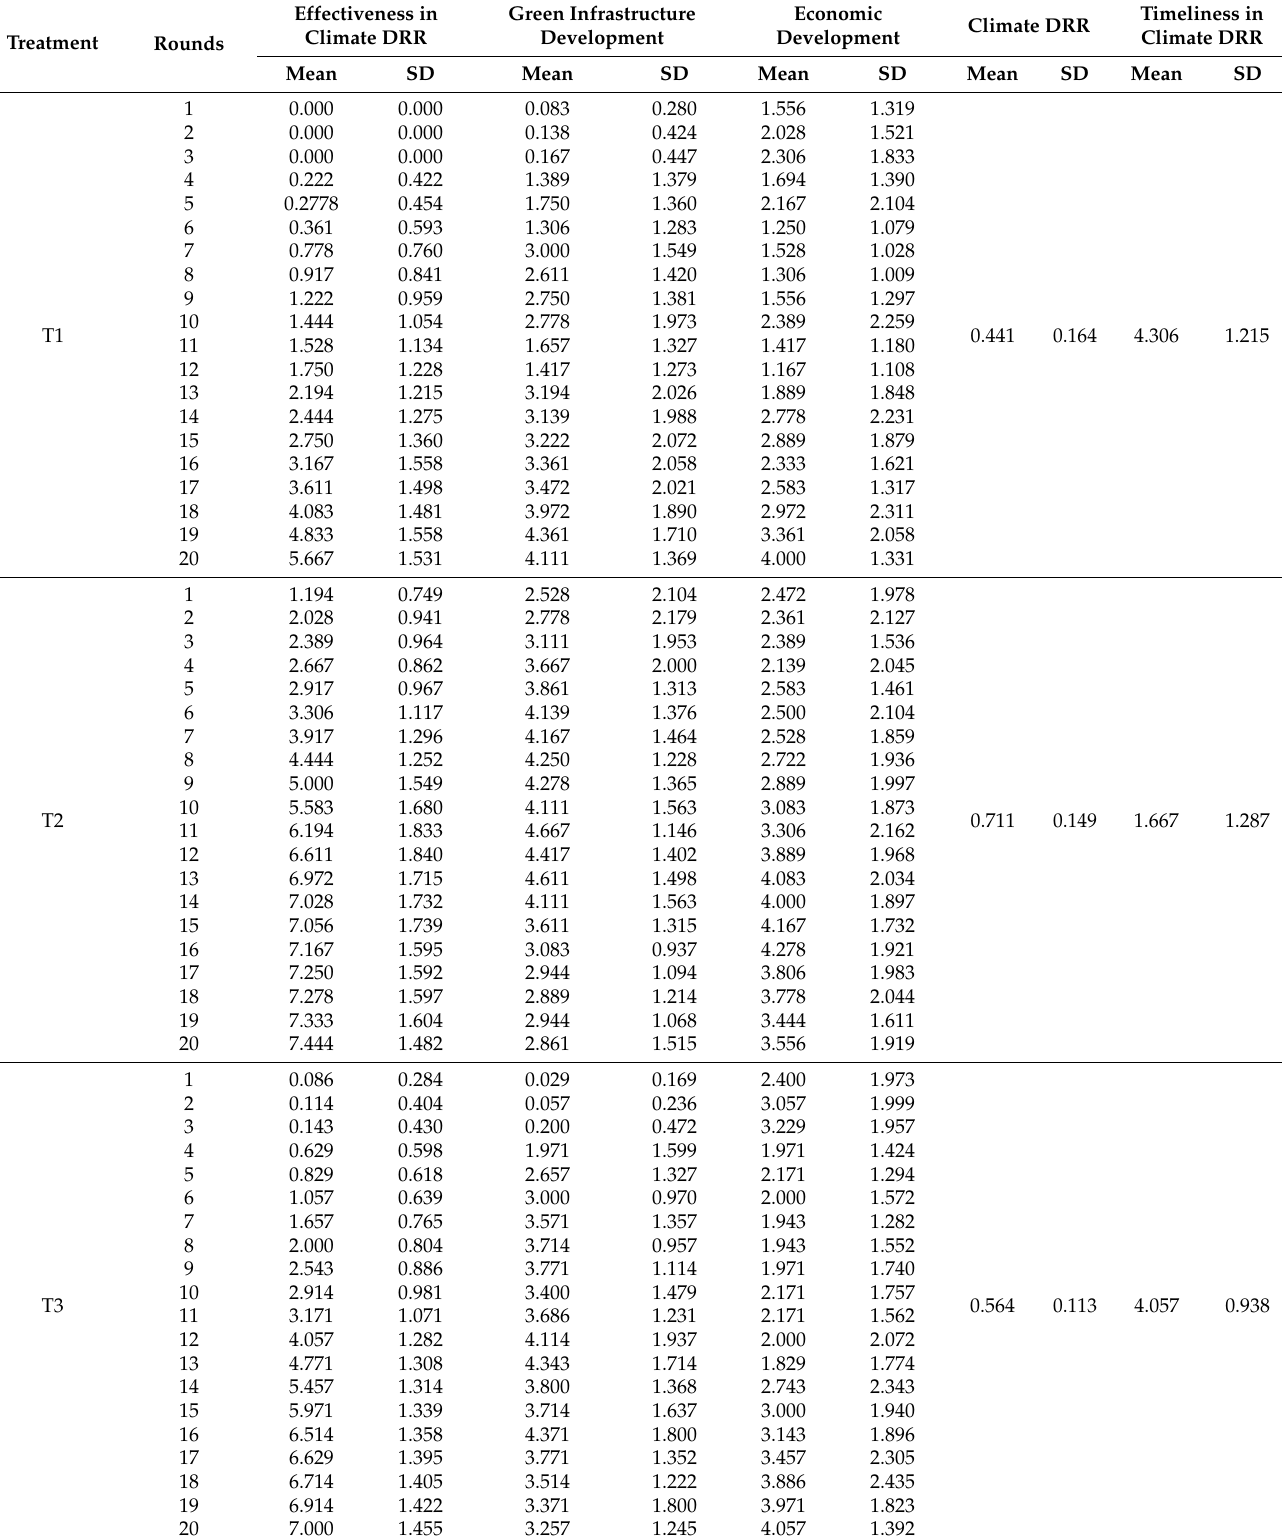
Table A1. The indicator variables recorded in the in-game